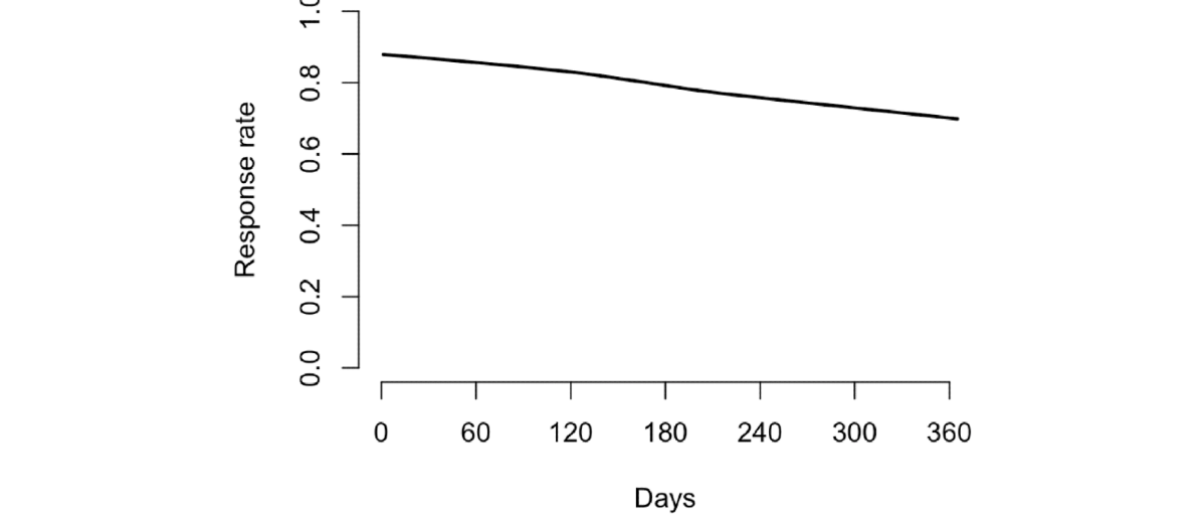
Figure 3. Predicted response rates over the 12-month intervention using a locally weighted scatterplot smoothing (LOWESS) curve.